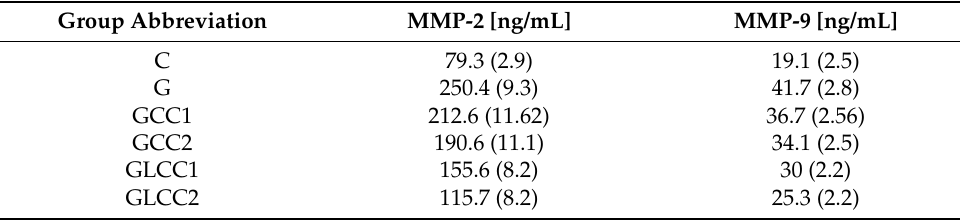
Table 3. Serum levels of matrix metalloproteinases.